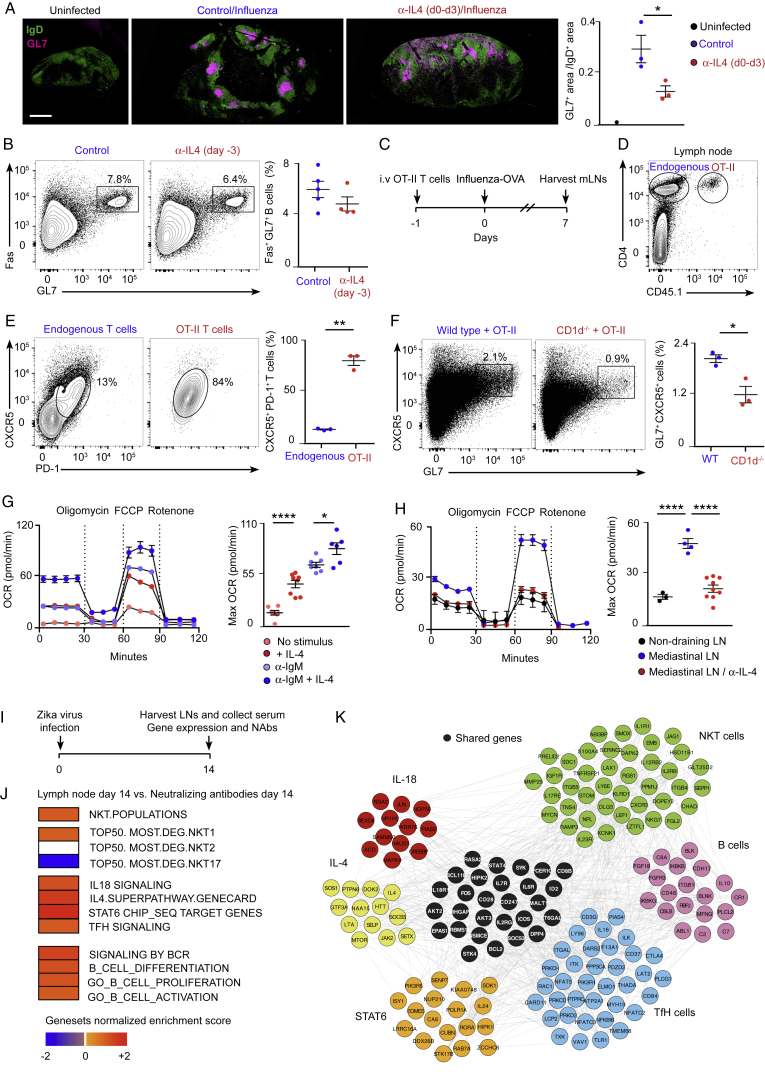
Importance of Early IL-4 Production on B Cell Immunity, Related to Figure 7(A) Representative confocal microscopy images of mediastinal lymph node sections from mice that were treated as in Figure 7E. Sections were stained with antibodies to the B lymphocyte marker, IgD (green) and the germinal center marker, GL7 (magenta). Scale bar, 450 μm. Quantification of the germinal center area in confocal images by ImageJ is shown in the right chart.(B) Flow cytometry analysis at day 8 of mediastinal lymph nodes from wild type mice that were treated with PBS or anti-IL4 blocking antibody on day −3, and infected with 200 PFU of influenza virus at day 0. Contour plots show Fas+GL7+ germinal center cells. The responses are quantified in right charts.(C) Experimental scheme showing the strategy for the generation of antigen-specific TfH cell precursors.(D–F) Flow cytometry analysis of mediastinal lymph node cells from mice treated as in (C). Representative contour plots display (D) the gating strategy used to differentiate endogenous CD4+ T cells from adoptively transferred OT-II cells, (E) the percentage of endogenous and exogenous cells bearing the TfH cell markers PD-1 and CXCR5 and (F) the percentage of B cells that acquire GL7 marker. Quantifications are shown on the right charts.(G and H) OCR at baseline and after sequential treatment with oligomycin, FCCP and Rotenone of B cells that were (G) stimulated ex vivo with anti-IgM and/or IL-4 or (H) isolated from lymph node cells of influenza-infected mice (day 3). Bar charts show the respiratory capacity obtained as (OCR after FCCP)- (basal OCR). Each dot represents an individual measurement.(I) Experimental scheme showing Zika virus infection strategy and time points at which lymph nodes and serum were collected from macaques.(J) Linear regression model of gene signatures for NKT cells, TfH cells, B cells, IL-4, STAT6 and IL-18 from harvested lymph nodes at day 14 with neutralizing antibodies measured in plasma at day 17. Red squares represent positive correlation, blue squares represent negative correlation and white squares represent no significant correlation.(K) Gene interacting network inference using GeneMANIA software representing interconnectivity of NKT, TfH cells, B cells, IL-4, STAT6 and IL-18 pathways and the co-expression of their leading genes.Unless stated, each dot represents a single mouse. Horizontal bars – mean; error bars – SEM. Data are representative of two independent experiments. Statistical analysis, two tailed Student’s t test, ∗p < 0.05, ∗∗p < 0.01 and ∗∗∗∗p < 0.0001.